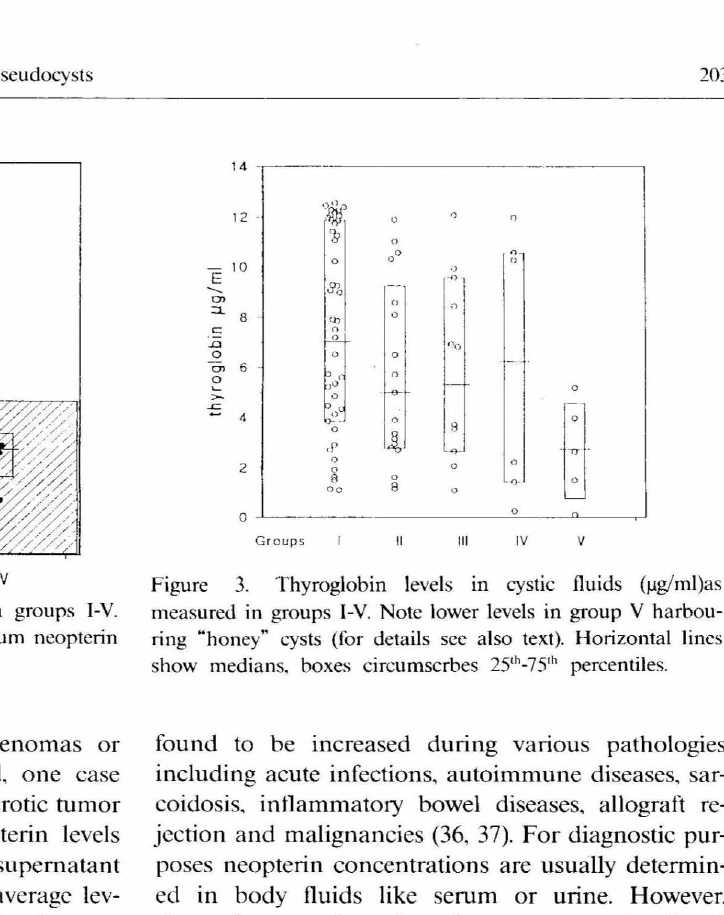
Figure 3. Thyroglobin levels in cystic fluids (Jlg/ml)as measured in groups I-V. Note lower levels in group V harbou ring "honey" cysts (for details see also text). Horizontal lines show medians, boxes circumscrbes 25 1h -75 1h